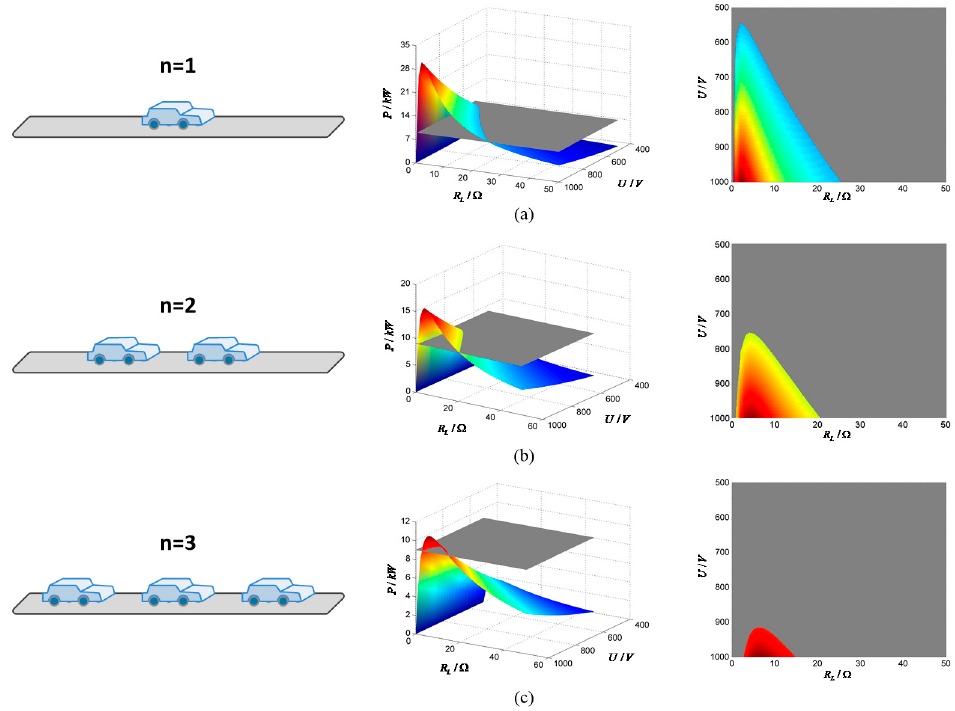
Figure 3. Range of the transmitting-side voltage and load value corresponding to different n in the charging areas ( a ) n = 1; ( b ) n = 2; ( c ) n = 3.